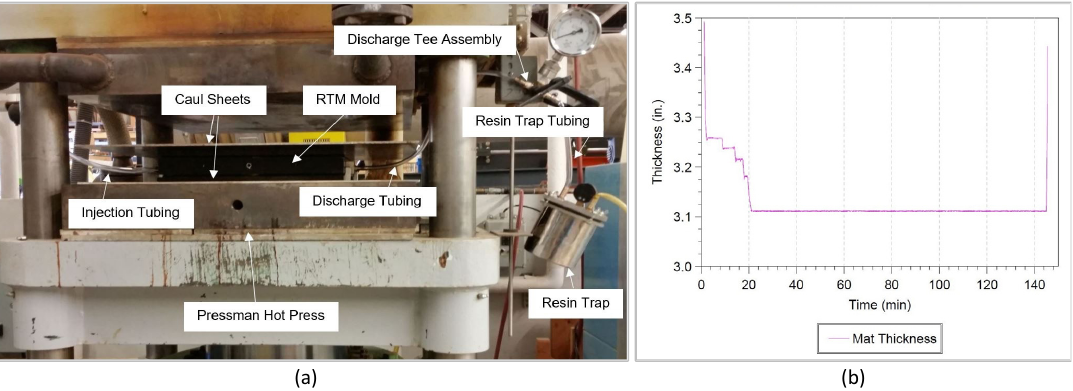
Figure 3. ( a ) CRTM setup of the mold in the press for applying pressure to the mold, and ( b ) the press schedule showing stepwise closing of the mold to it its final closed position.